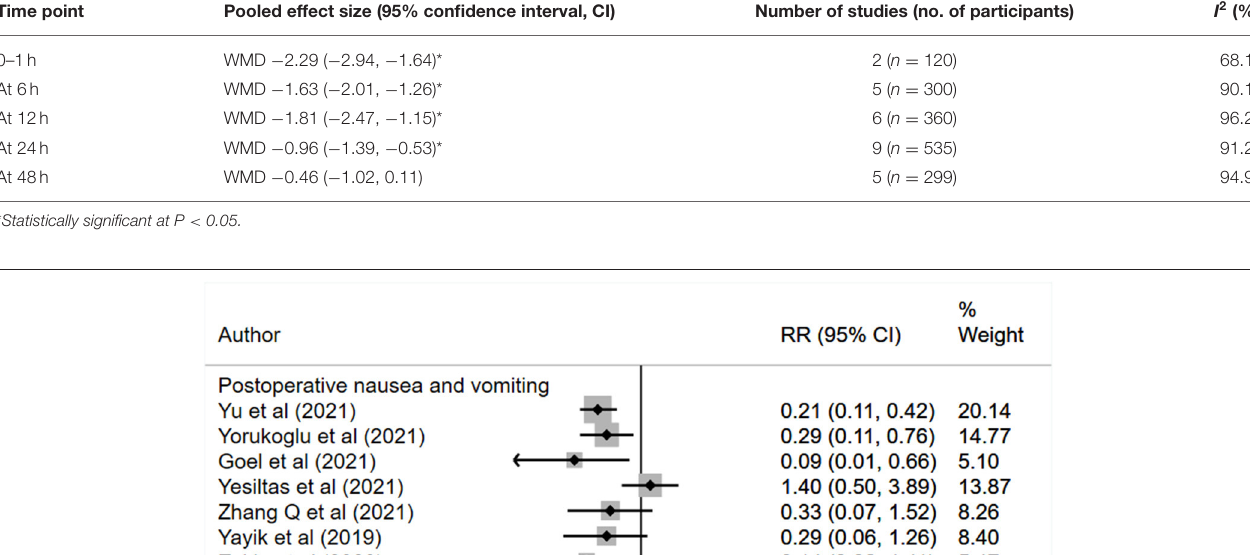
TABLE 4 | Summary result of the postoperative pain scores at movement, comparing subjects with erector spinae plane block to those with placebo or no block. Time point